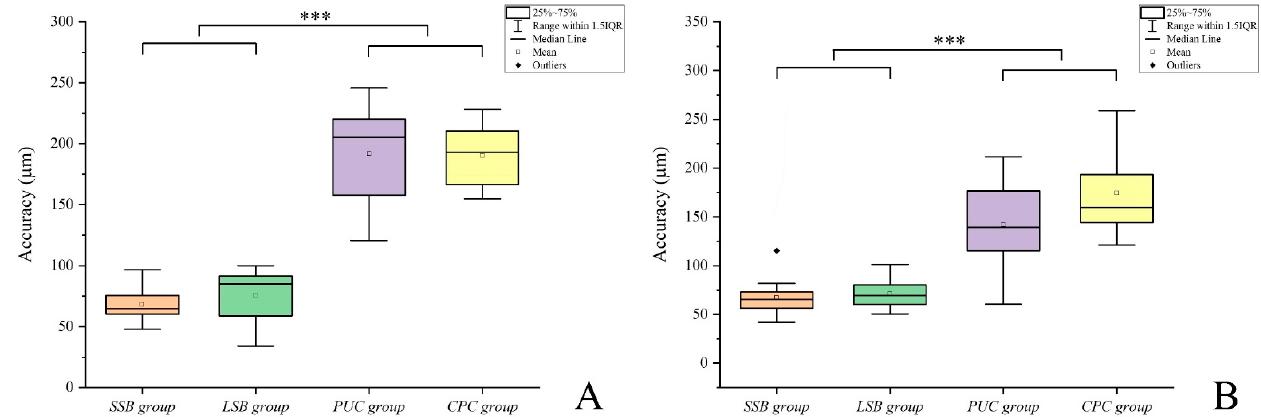
Figure 6. Comparison of accuracy of proximal contact among four groups. ( A ) Mesial contact of crowns; ( B ) distal contact of crowns. SSB, short scan body; LSB, long scan body; CPC, coping plastic cap; PUC, pick-up coping. ***, p < 0.001.